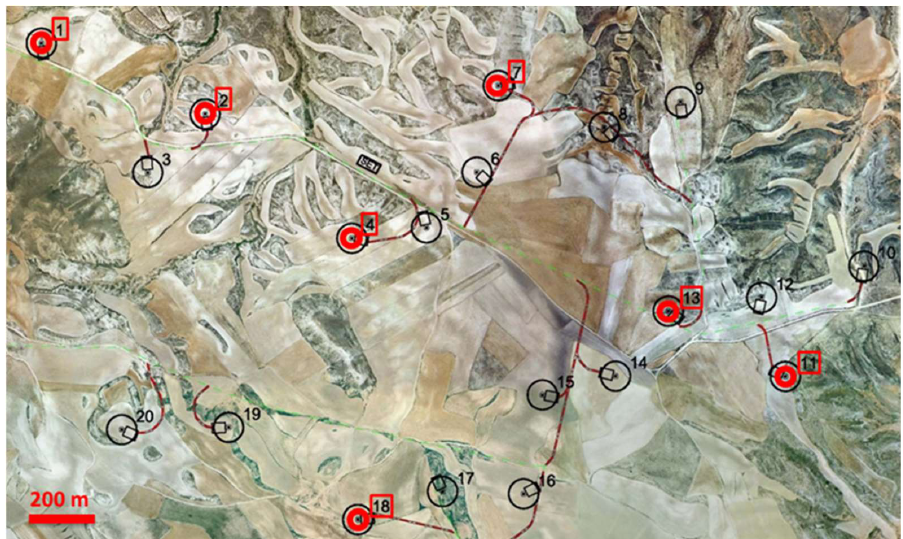
Figure 1. Topographic distribution of the wind turbines in the wind farm. Investigated units are denoted using a red circle.